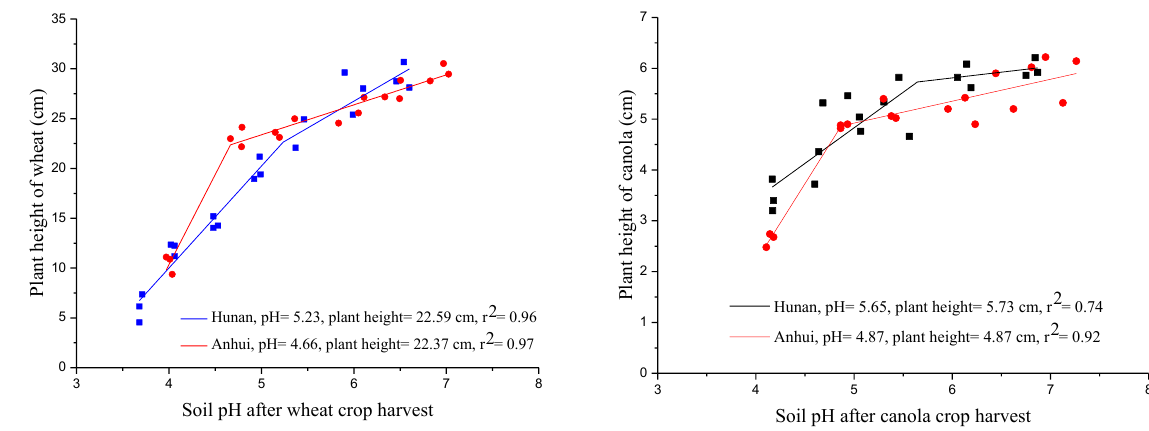
Figure 2. Plant heights of wheat and canola as a function of soil pH of the Ultisols from Hunan and Anhui. The fitted equations were significant at P <0.01.